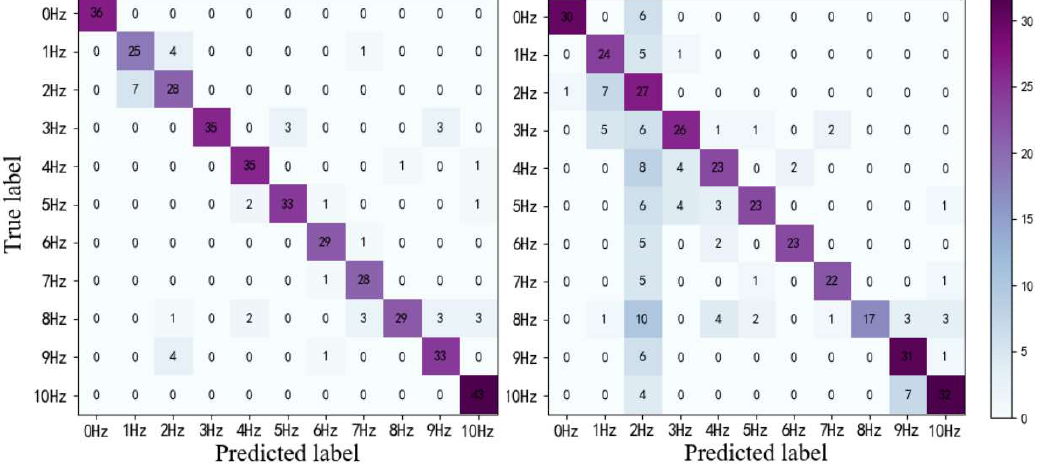
Figure 10. Confusion matrixes. ( a ) 3DCNN-CONVLSTM; ( b ) 3DCNN.